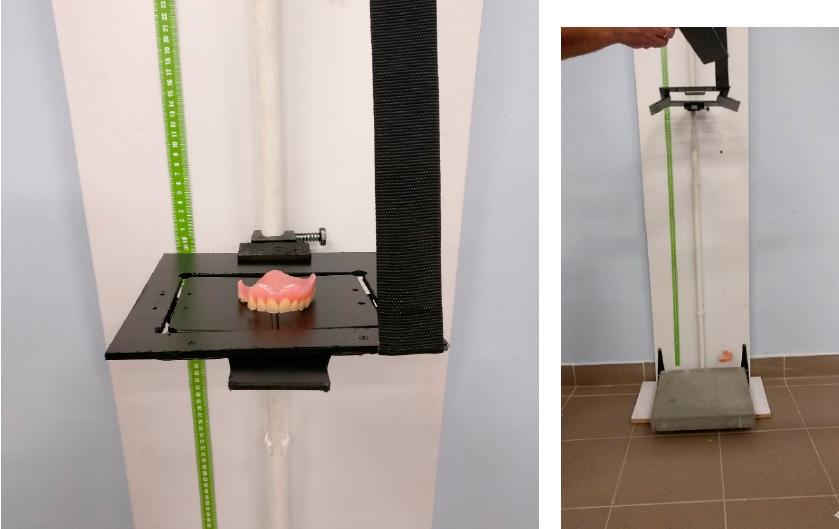
Figure 6. The view of the created test bench for the fall from height. The substrate (the material on which the dental prosthesis falls) was a paved concrete slab (B20 concrete class according to PN-B-03264: 2002/Ap1 2004). Each product was placed on two perpendicular platforms and the hinges were released, which caused the product to fall from a certain height in accordance with the principle of gravity.